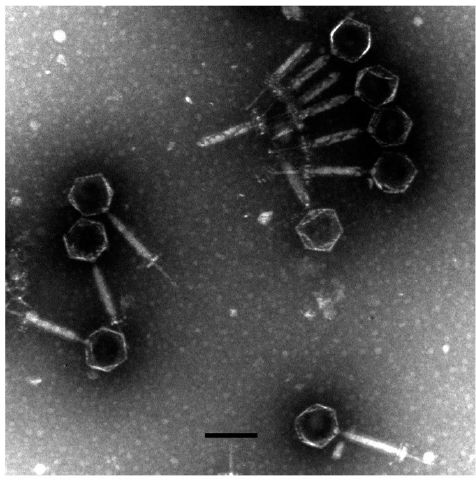
Figure 1. The morphology of vB_AviM_AVP (AVP). AVP was negatively stained with 2% phosphotungstic acid (PTA) and examined by transmission electron microscopy (TEM) at an accelerating voltage of 80 kV. The scale bar represents 100 nm.